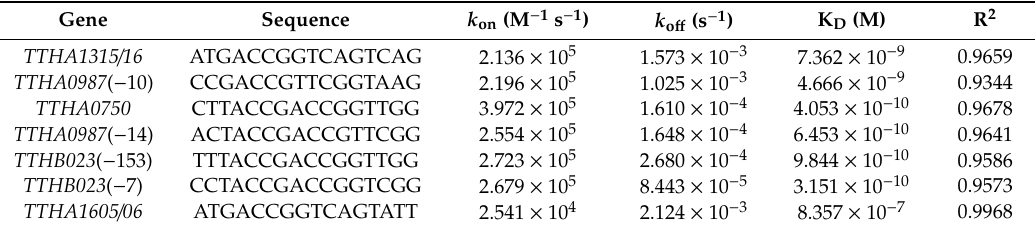
Table 3. TTHB023-promoter binding parameters.